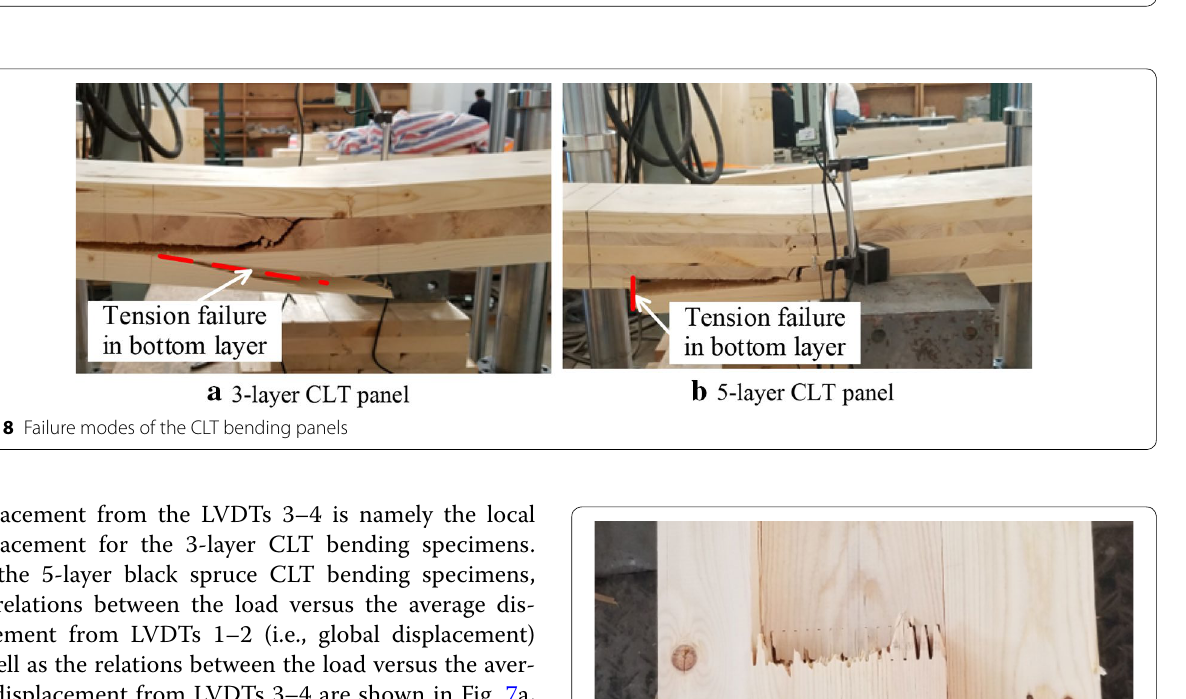
Fig. 7 The 5-layer CLT bending specimens